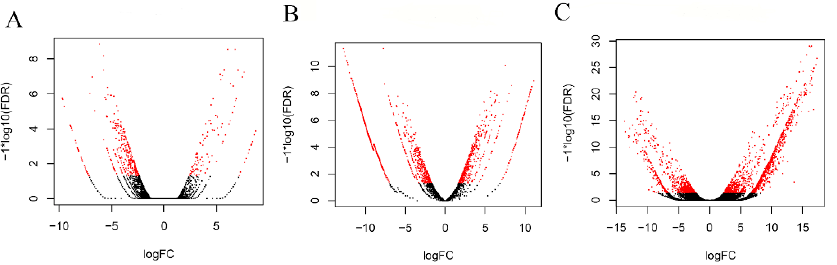
Figure 1. Volcano plots representing the differentially expressed genes between virgin and mated flies in the three dissected tissues: ( A ) testes, ( B ) male accessory glands with ejaculatory bulb and ( C ) lower female reproductive tract. The Y-axis represents significance, and the X-axis represents logarithmic fold change. The red dots represent differentially expressed genes with a p -value < 0.05.